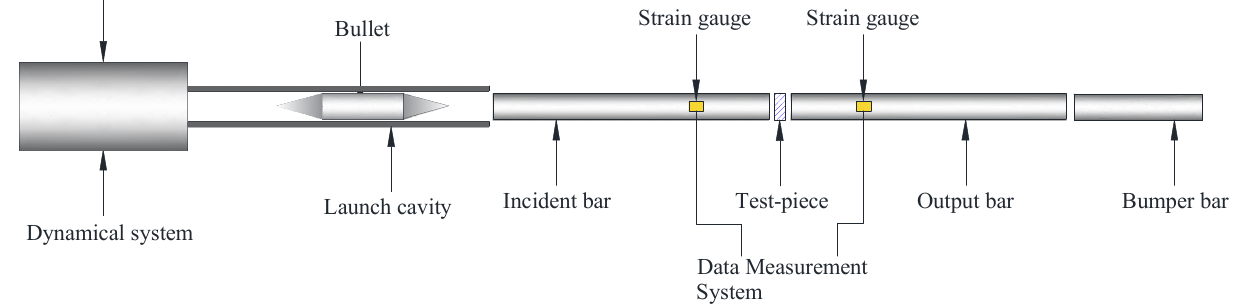
Figure 2. Schematic diagram of split Hopkinson bar device.